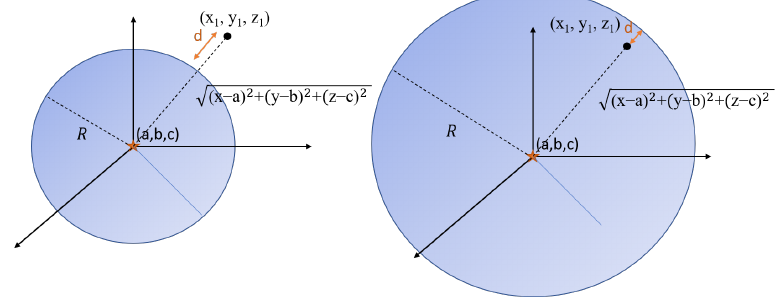
Figure 4. 3D model of objective